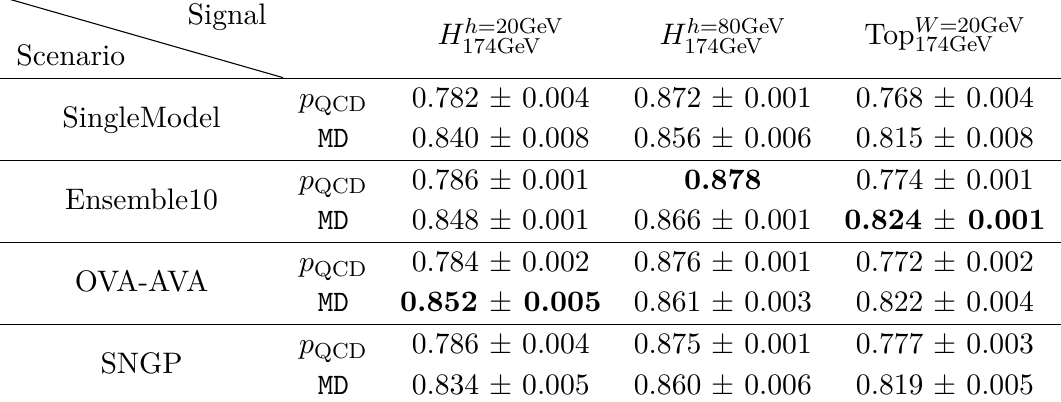
Table 2 . OoD test AUCs for different model training strategies and anomaly scoring functions ( p QCD and Mahalanobis distance MD ). Standard deviations are calculated from 10 random runs, except that for the Ensemble model we bootstrap for 5 times from 20 individual models. (In the case of a too-small ( < 0 . 001 ) standard deviation, we omit it in the table.) For each test signal, the highest AUC is highlighted in